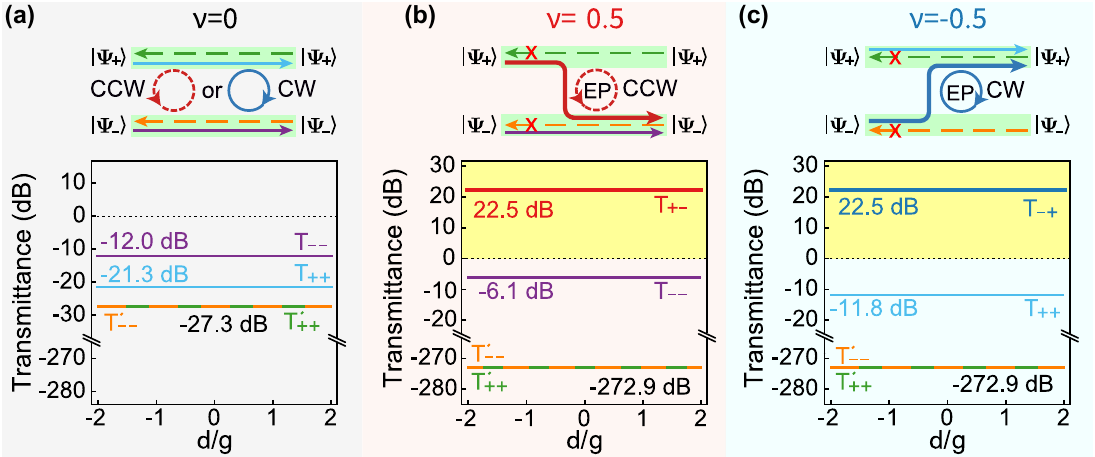
from the input eigenmode of forward transmissions | 𝜓 mn